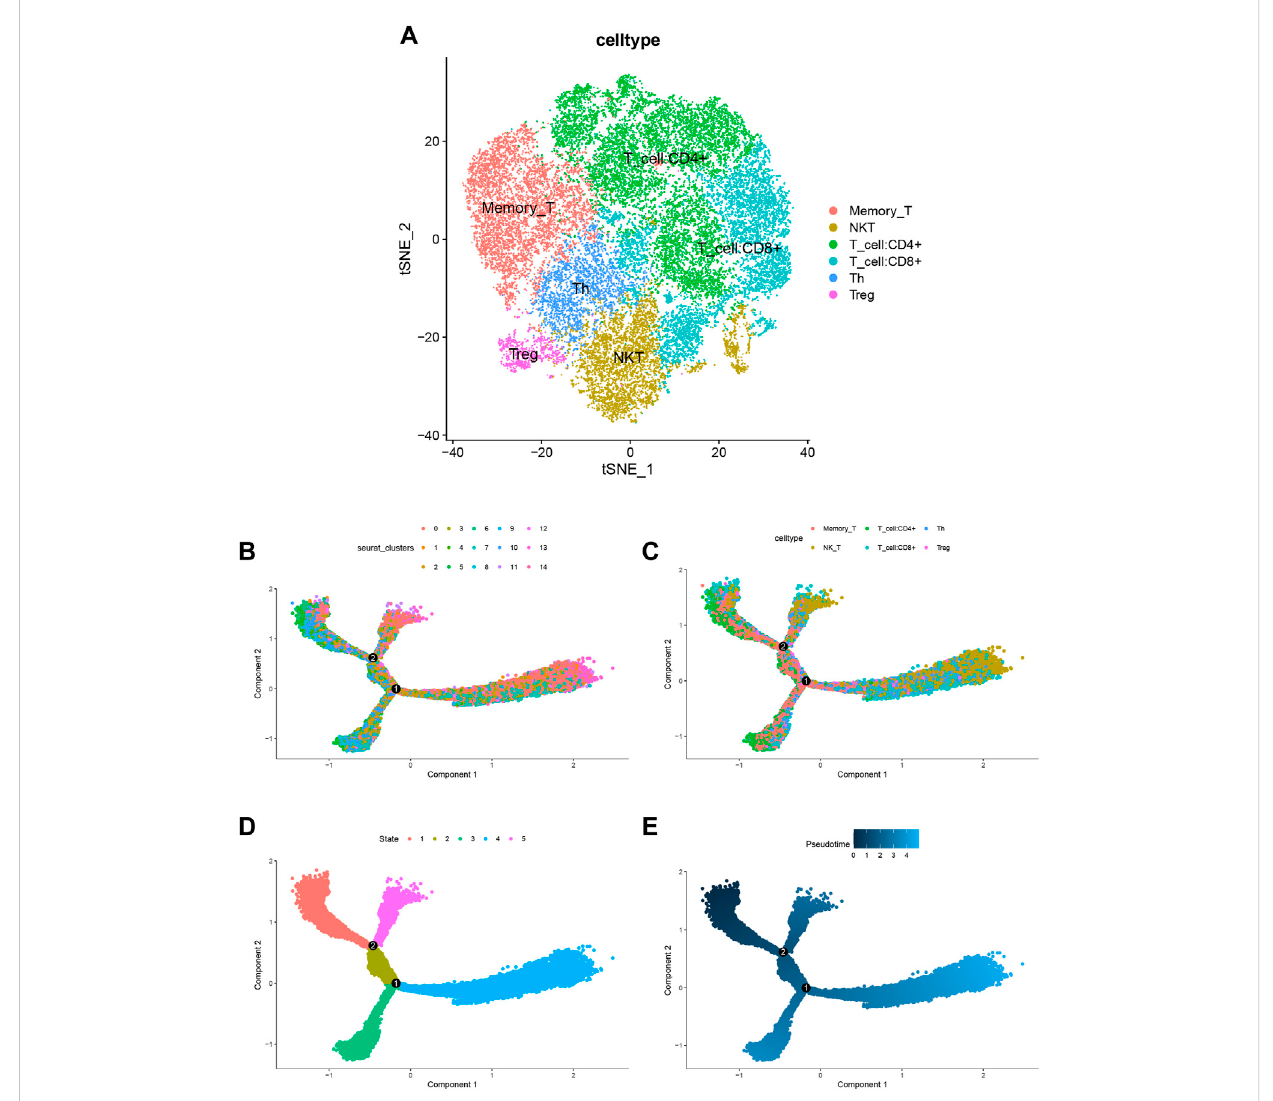
FIGURE 8 Trajectory analysis for T cells. (A) tSNE diagram for T cells. T cells differentiate into Memory T cells, NK T cells, CD4 + T cells, CD8 + T cells, Th T cells and Treg T cells. (B – E) Pseudotime analysis for T